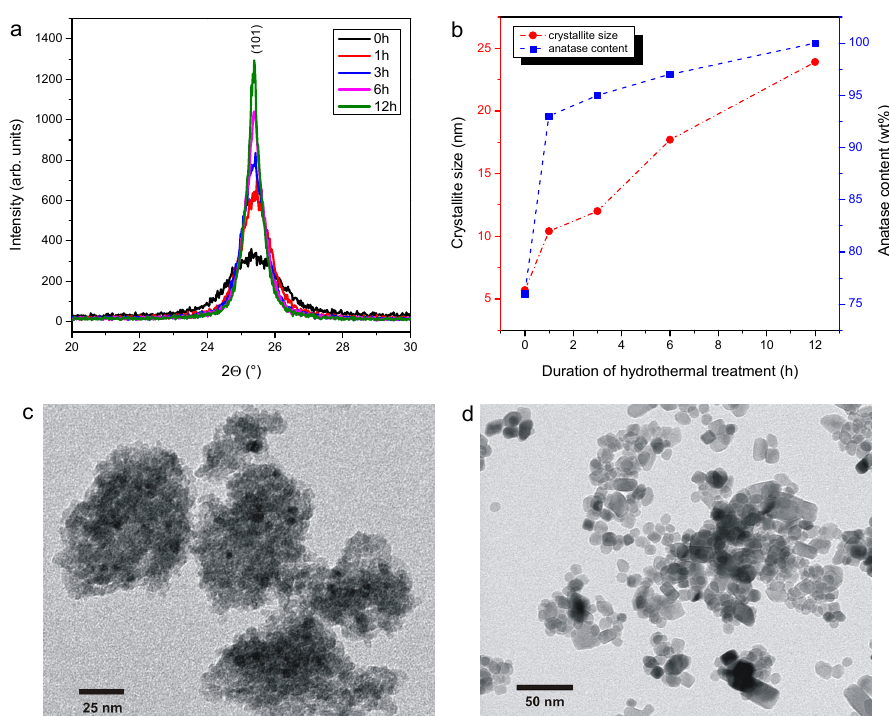
Figure 1. Structural and morphological properties of PF-co-doped TiO 2 nanoparticles: X-ray diffrac- tograms ( a ); crystallite size and anatase content of PF-TiO 2 nanoparticles ( b ); representative TEM images of PF-TiO 2 /0 h and PF-TiO 2 /12 h samples ( c , d ).